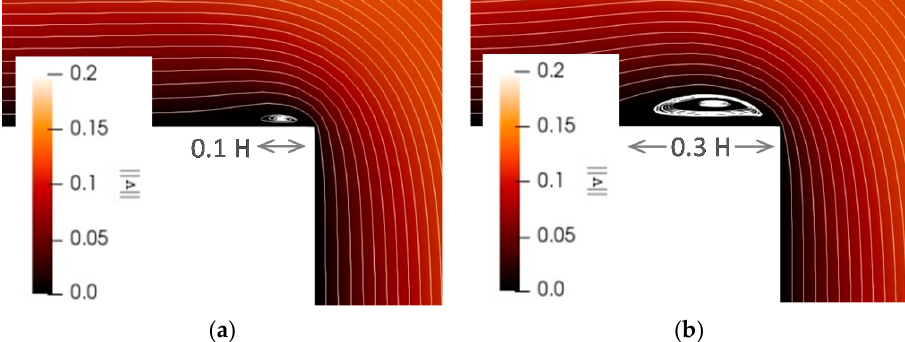
Figure 12. Upstream elastic vortices, effect of viscosity ratio (polymer flow) for Wi = 1 and El = 1·10 6 : ( a ) elastic vortex for β = 0.4; ( b ) elastic vortex for β = 0.1. ( a ) elastic vortex for β = 0.4; ( b ) elastic vortex for β =